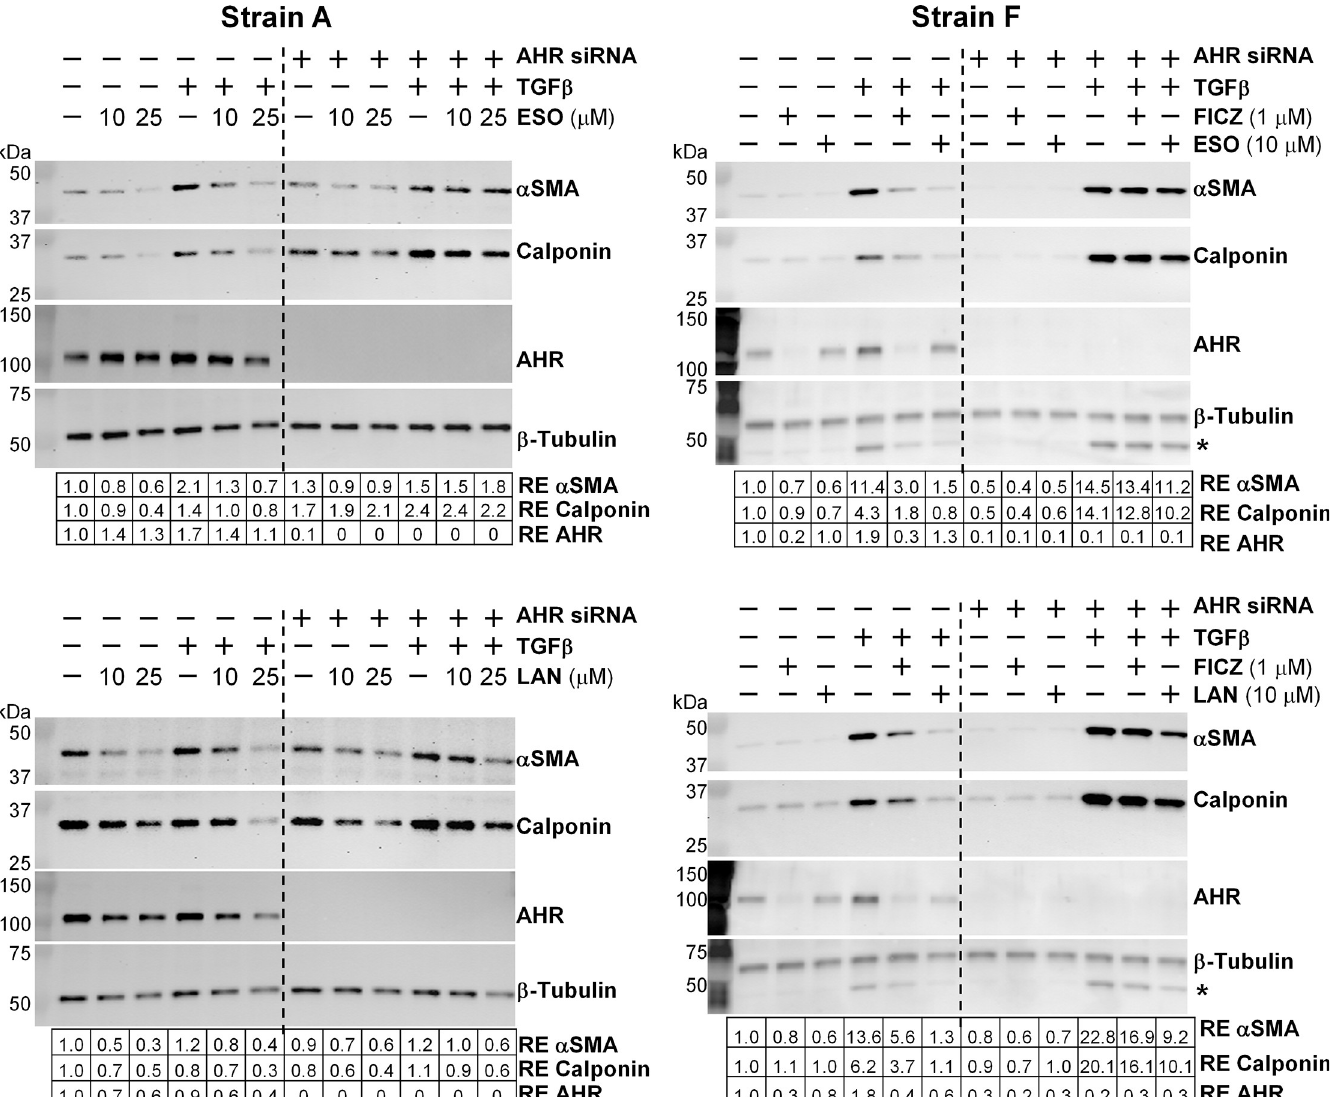
Fig 8. PPIs prevent TGF β -induced myofibroblast marker expression in an AHR-dependent manner. After reduction of AHR expression with AHR specific siRNA, FICZ or a proton pump inhibitor (ESO = esomeprazole; LAN = lansoprazole) was added every 24h for 96h. After the first 24h, 1 ng/mL TGF β was added. Cell lysates were collected at the end of 96h and analyzed for α SMA, calponin, AHR, and β -tubulin expression using Western blotting. Two representative strains of different TED orbital fibroblasts are shown, Strain A was used in the left two panels and Strain F was used in the right two panels. RE = relative expression of protein bands compared with first band on the left. � The band beneath the β -tubulin band is α SMA that was previously detected on this membrane.